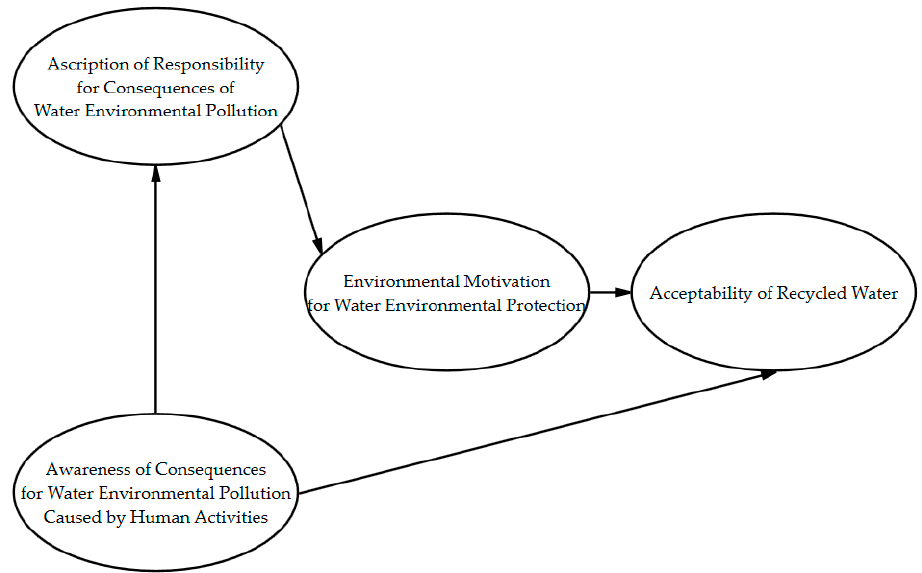
Figure 5. Logic frame diagram of improved recycled NAM.